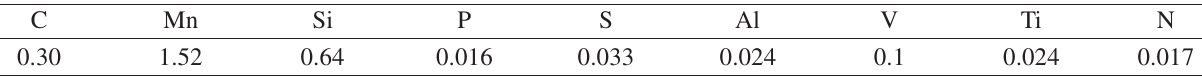
Table 1. Chemical composition of the tested steel (wt.%).